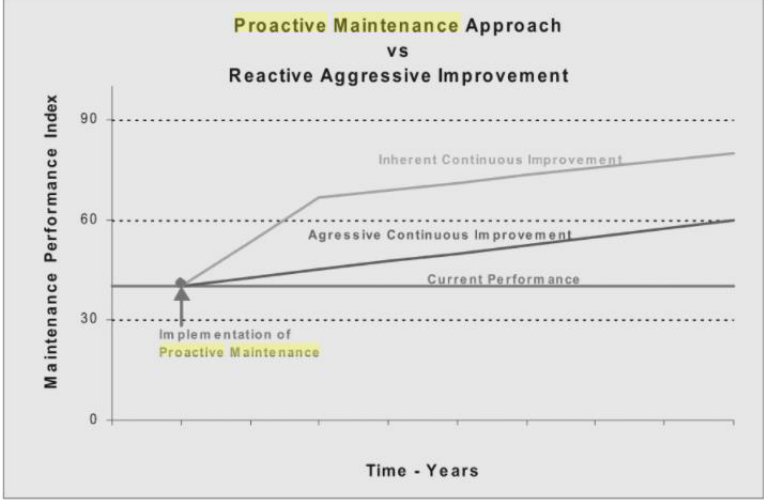
Figure 6: Proactive Maintenance Approach vs Reactive Maintenance Approach; Source: (Smith and Hawkins,